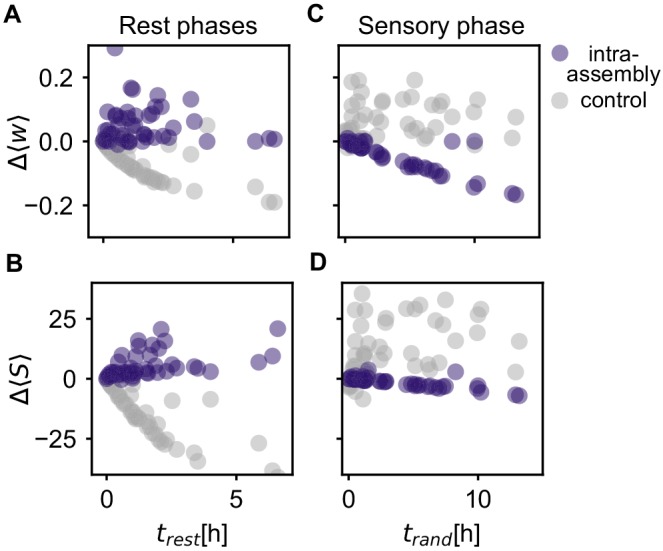
Connectivity changes in individual phases.Rest phases strengthen intra-assembly connectivity and weaken extra-assembly connectivity. (A) Change of the average synaptic weight between neurons within the same assembly (blue) and between neurons outside the assemblies (grey) during individual rest phases depending on the length of the resting interval. (B) Change in the mean number of stable synapses (synapses above wo⁢f⁢f) during individual rest phase. Both intra-assembly weights and number of connections grow, whereas connectivity outside the assemblies decays. (C) During the sensory intervals, the opposite occurs. (D) Change in the mean number of stable synapses during sensory intervals. .